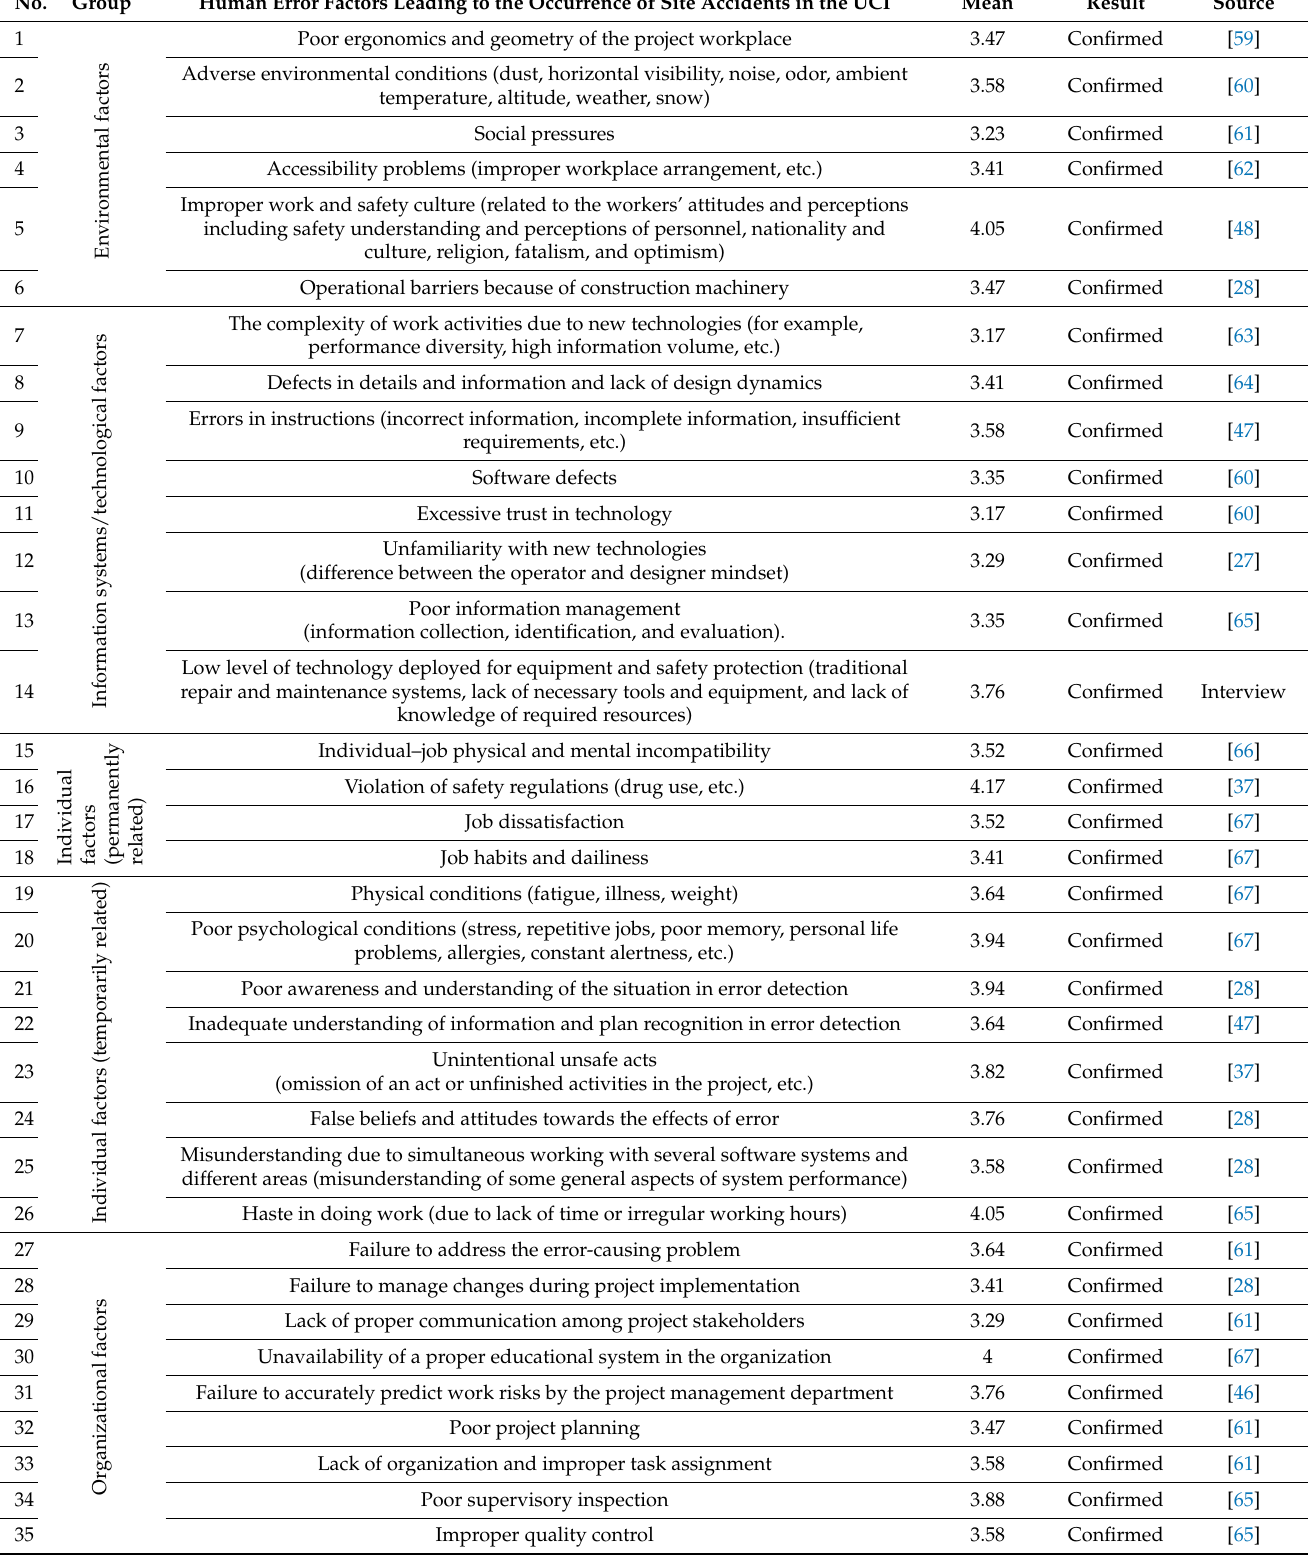
Table 2. The overall results after completion of the third round of the Delphi